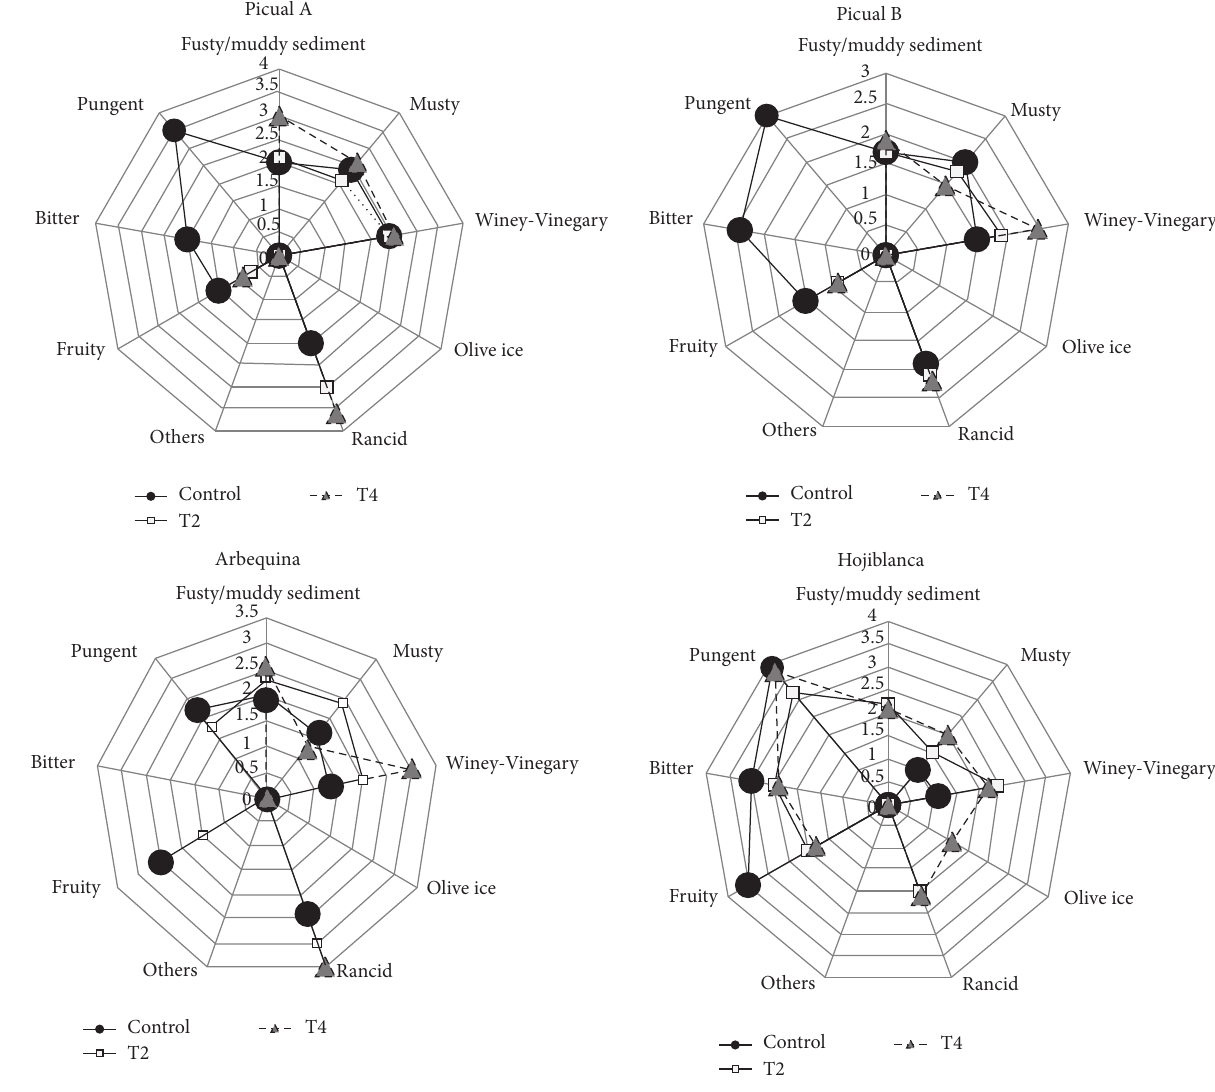
Figure 4: Sensory profile of the olive oils after 3 weeks at 40 ∘ C (T2) and 3 weeks at 60 ∘ C